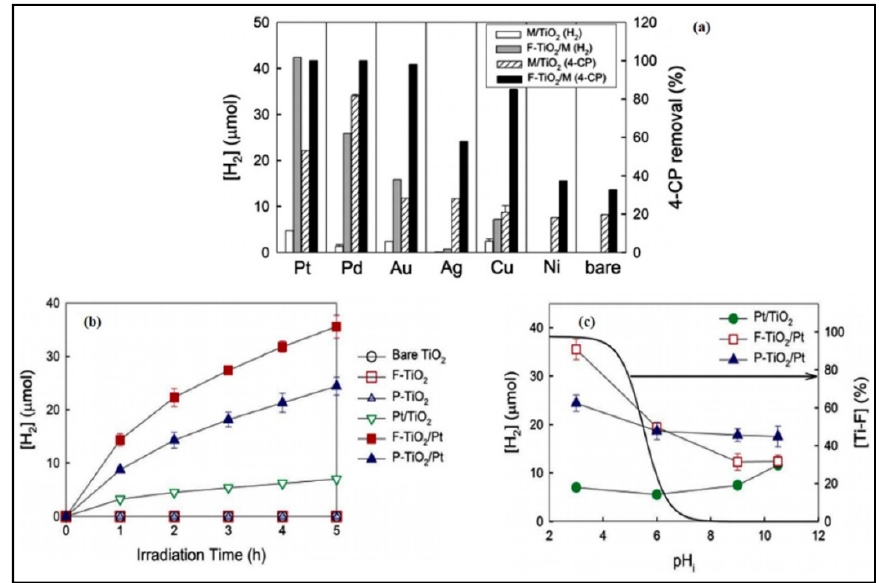
Figure 14. ( a ) Production of H 2 with the simultaneous degradation of 4-CP in the suspension of M/TiO 2 and F-TiO 2 /M (M= Pt, Pd, Au, Ag, Cu, and Ni), ( b ) Production of H 2 in the suspension of bare TiO 2 , F-TiO 2 , P-TiO 2 , Pt/TiO 2 , F-TiO 2 /Pt, and P- TiO 2 /Pt with 4-CP, and ( c ) effect of pH on the production of H 2 . Adapted with permission from reference [11] . Copyright 2012 Royal Society of